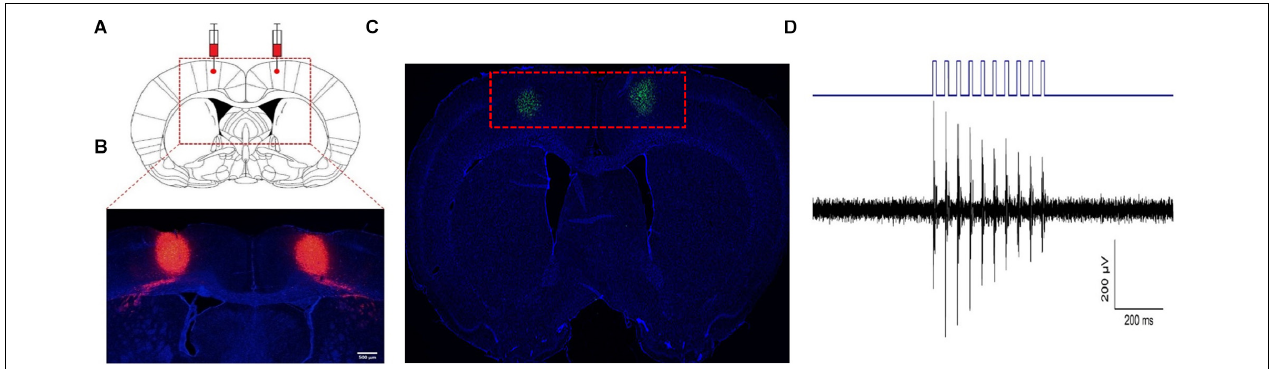
FIGURE 2 | Activation of M1 glutaminergic neurons. (A, B) The region where the virus is injected and expressed. (A) The red dotted line box is the anatomical diagram of the rat’s brain injected with the virus. (B) The red dotted line box is the expression of the virus at the corresponding position. (C) c-Fos staining of the M1 region after virus expression showed that c-Fos expression was found in the green part. (D) Electrophysiological detection of nerve cell discharge during light